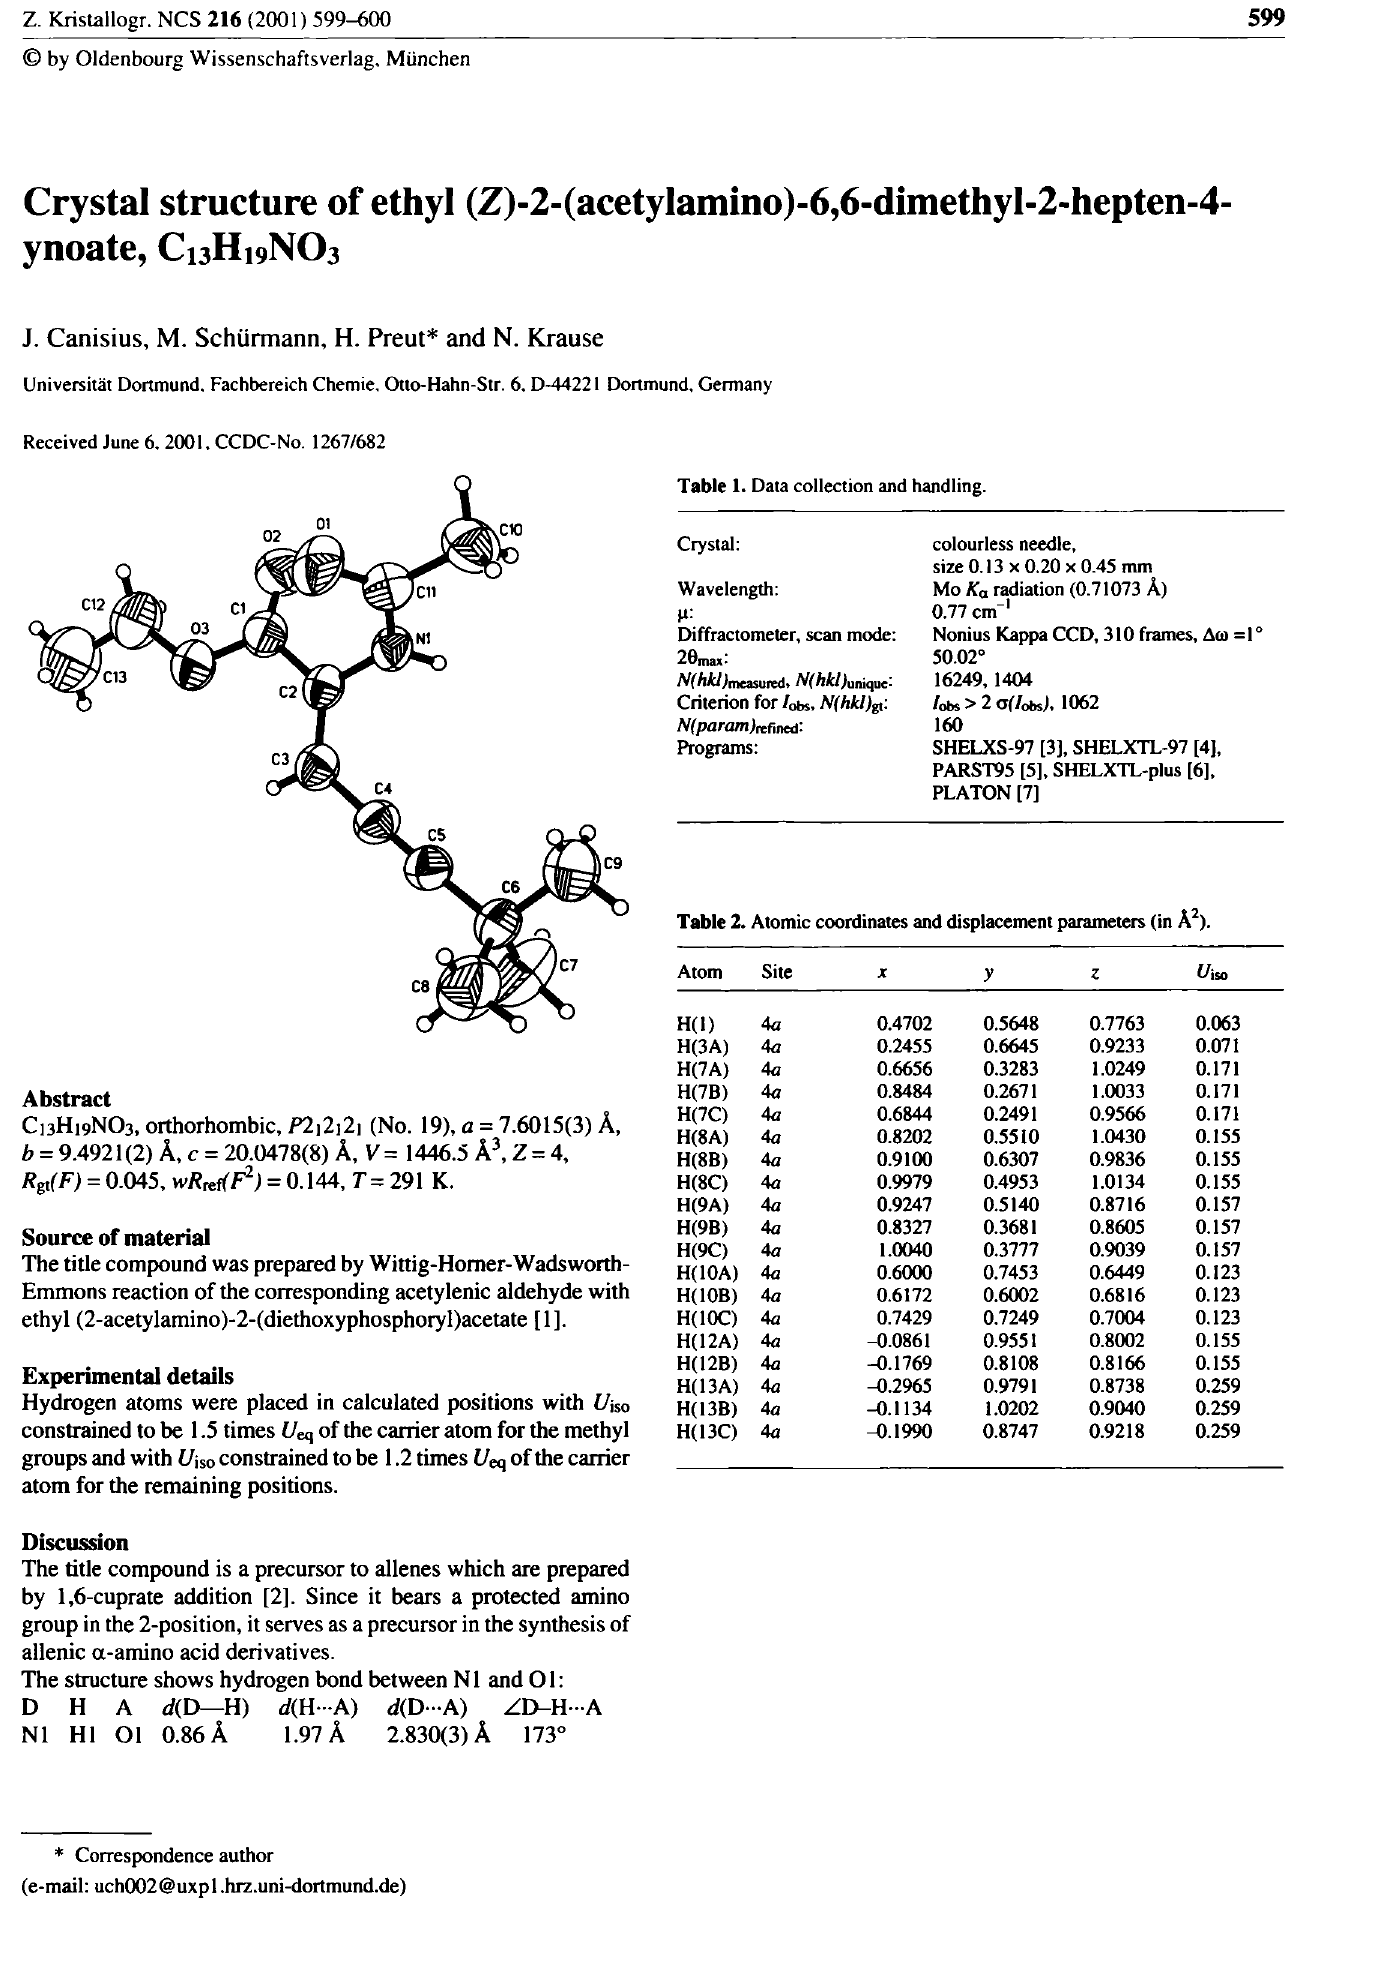
Table 1. Data collection and handling.